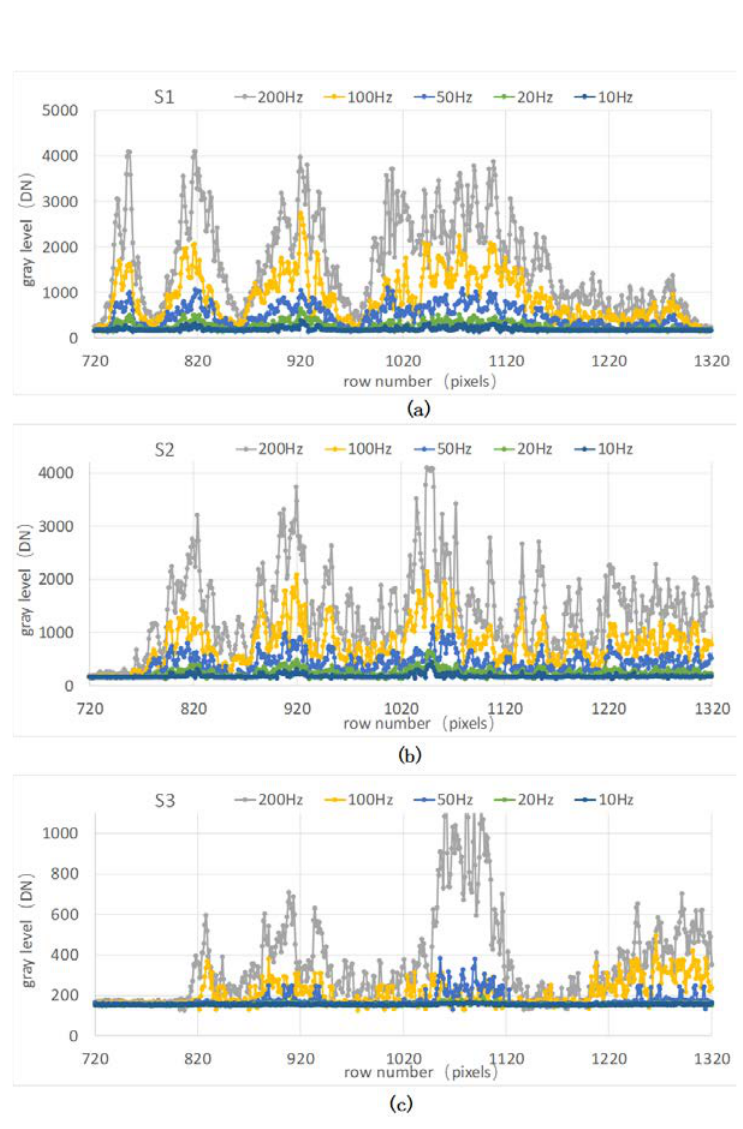
Figure 8. Cross-sections of the interference patterns in Figure 7c,d at different laser pulse frequencies: ( a ) cross-sections of S1; ( b ) cross-sections of S2; and ( c ) cross-sections of S3.